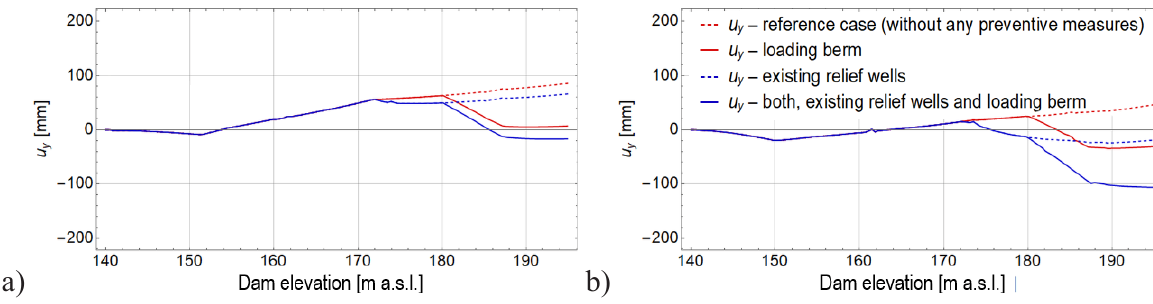
Fig. 9. Horizontal displacement ( u x [mm]) as a function of dam elevation: a ) cross- section VIIIN and b ) cross- section VaN.